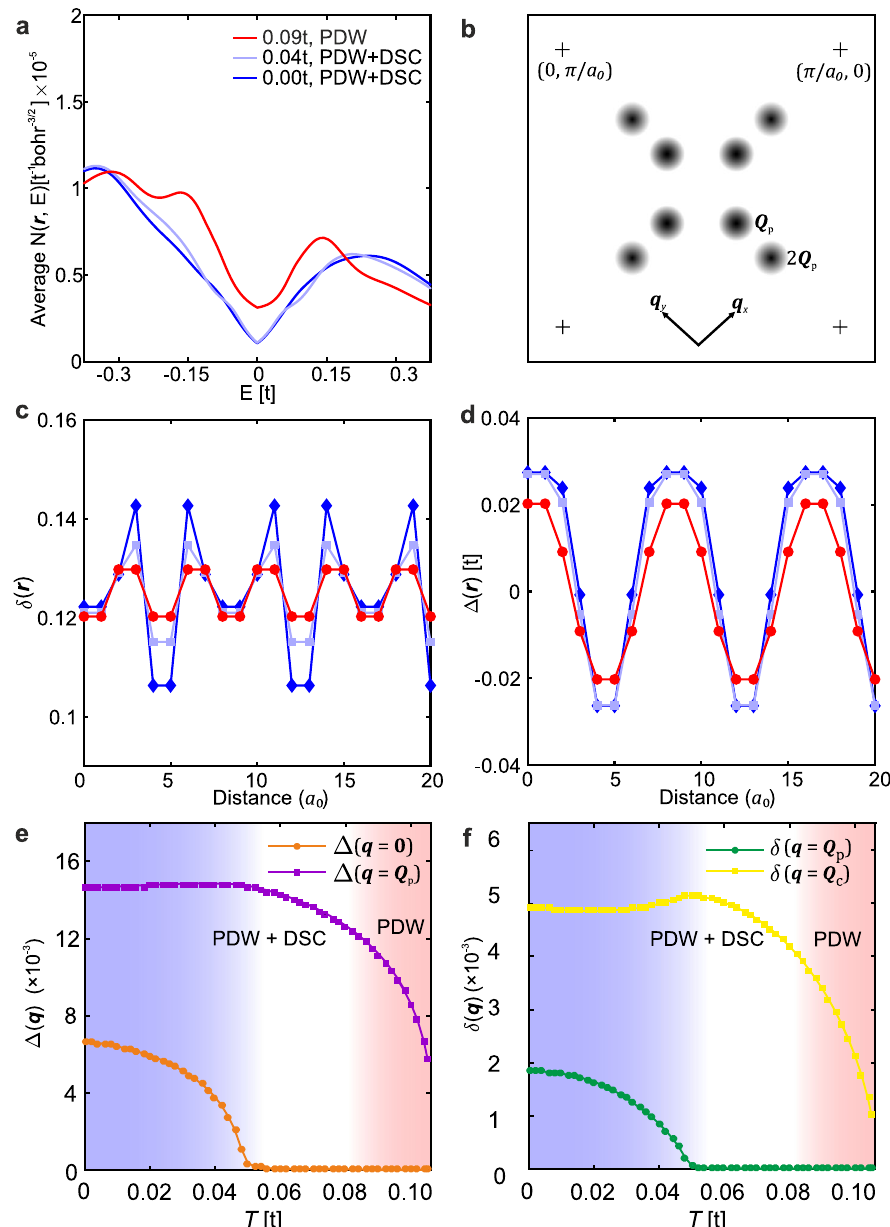
Fig. 2 Predicted temperature-evolution of the average local density of states ( N ( r, E )), hole density ( δ ), and d-wave gap order parameter ( Δ ) for the PDW state. a Continuum LDOS N ð r ; E Þ spatially averaged over a period of PDW (8 a 0 ) at low-temperatures ( T = 0 and T = 0.04 t ) and pure PDW state at a high temperature ( T = 0.09 t ) obtained using parameter set doping p = 0.125, t = 400 meV, t ’ = -0.3 t and J = 0.3 t . PDW + DSC state exhibits V-shaped nodal LDOS due to the presence of the DSC component. Pure PDW state has Bogoliubov-Fermi pockets (in contrast to nodes in PDW + DSC state), which leads to a large E = 0 LDOS. The LDOS is obtained after the effects of linear inelastic scattering i 0 þ þ i Γ is incorporated, where Γ ¼ α j E j and α = 0.25 using the experimental fi ts in ref. 55 . A non-zero LDOS at zero-bias in PDW + DSC state is a consequence of the fi nite arti fi cial broadening i 0 þ . b q-space schematic showing the most prominent wavevectors Q P = [(±1/8, 0); (0, ±1/8)]2 π / a 0 and 2 Q P appearing in the Fourier transform of the mean- fi elds and other related quantities. c Spatial variation of hole density ( δ ) in PDW + DSC state (at T = 0 and T = 0.04 t ) and pure PDW state (at T = 0.09 t ). Hole density modulates with a periodicity of 8 a 0 in PDW + DSC state due to presence of the DSC component and a periodicity of 4 a 0 in pure PDW state due to the absence of the DSC component, as expected from Ginzburg-Landau theories. d Spatial variation of d-wave gap order parameter in PDW + DSC state (at T = 0 and T = 0.04 t ) and pure PDW state (at T = 0.09 t ) exhibiting 8 a 0 -periodic modulations corresponding to the PDW component of the gap. e Temperature evolution of the uniform ( q ¼ 0 ) and PDW ( q ¼ Q P ) components of the d-wave gap order parameter in PDW + DSC state (0< T <0.085 t ) and pure PDW state (0.085 t < T <0.11 t ). The uniform component of the gap decreases sharply with temperature, becoming negligibly small but fi nite compared to the PDW component for 0.05 t < T <0.085 t . This ‘ fragile PDW + DSC ’ state is shown in white background. For T >0.085 t PDW + DSC state becomes unstable and only pure PDW state (shown in pink background) exists as a stable solution of the RMFT equations. f Temperature evolution of the q ¼ Q P and q ¼ Q C ¼ 2 Q P components of hole density ( δ ) in PDW + DSC and pure PDW state in the same temperature range as in ( e ). The q ¼ Q P component mirrors the temperature evolution of the uniform component of the gap in panel ( e ), as expected from Ginzburg-Landau theories. q ¼ Q C component is the dominant component at all temperature leading to 4 a 0 – periodic charge density